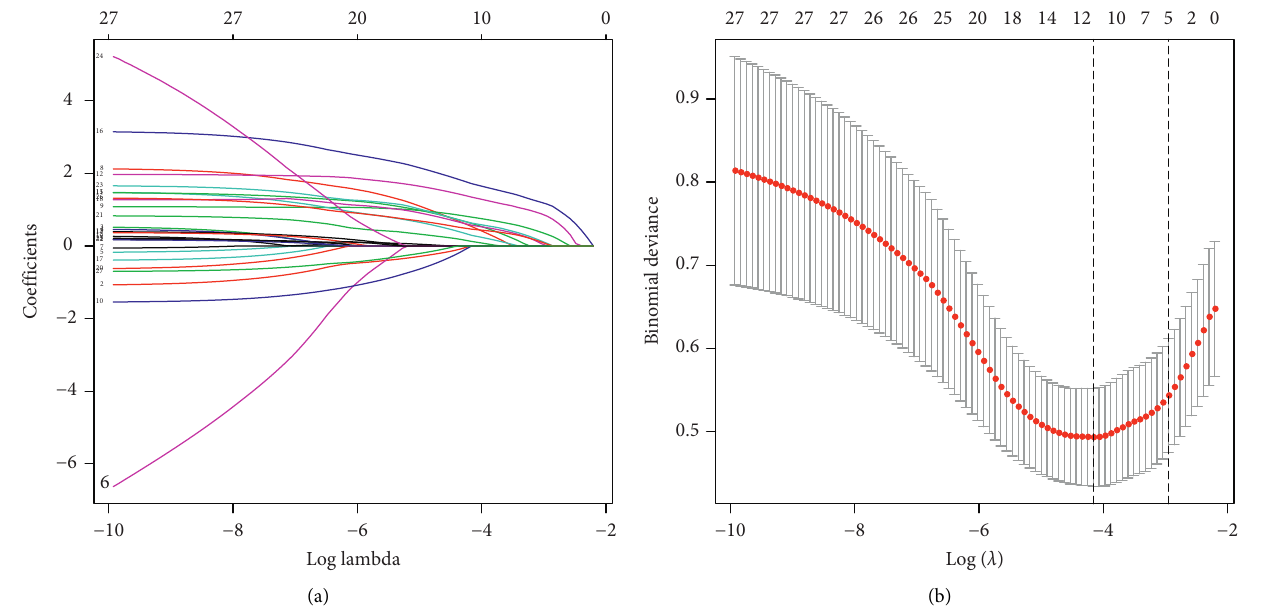
Figure 2: Lasso regression analysis was used to screen the potential predictors. (a) The results without cross-validation. (b) The results after cross-validation. Table 2: Prediction factors for early death in VMC patients.